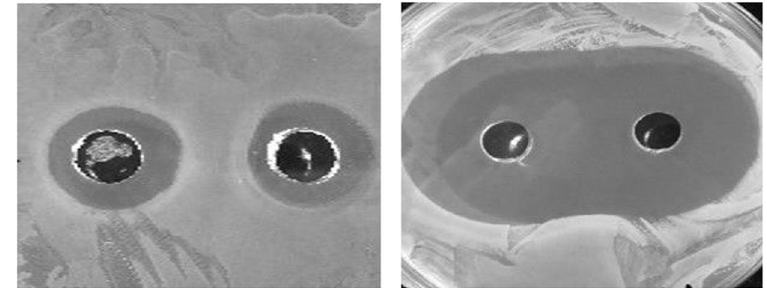
(gold) and 7.81 mgL − 1 (platinum and palladium) against A. baumannii and 31.25 mgL − 1 (gold, platinum and pal- ladium) against E. faecium . Silver showed equable antimicrobial efficacy as platinum, gold and palladium against A. baumannii ( ≤ 7.81 mgL − 1 ) and moderate efficacy against rest two pathogens. Copper was found to be the least active with an antimicrobial efficacy at 15.62 mgL − 1 against the two Gram-negative bacteria and 125.00 mgL − 1 against E. faecium (Table 3).